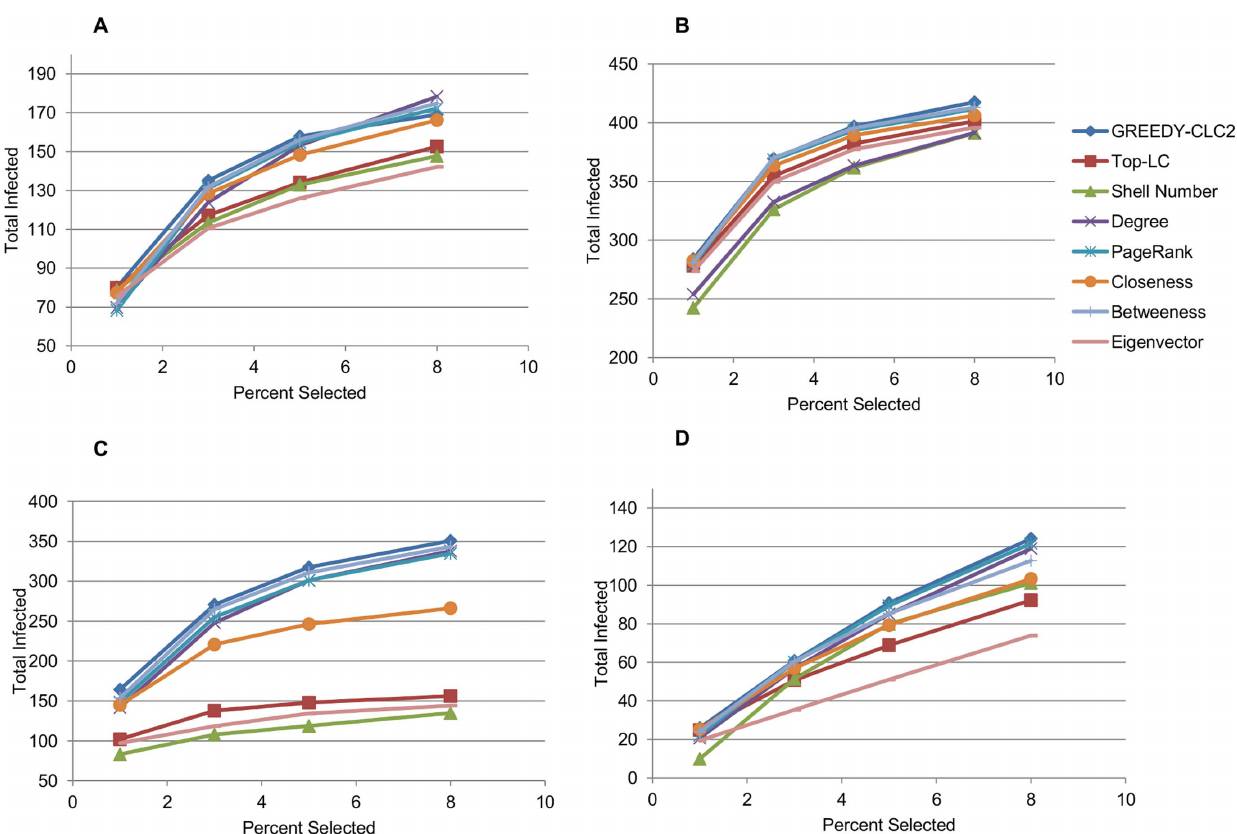
Figure 3. Spreading Impact of Sets Chosen with Various Centrality Measures. The number of vertices infected after 1000 simulation runs to 10 steps in the SIR model, averaged over five subgraphs for each datum. Sexual interaction, email, academic collaboration, and protein interaction networks are respectively graphs A, B, C, and D.